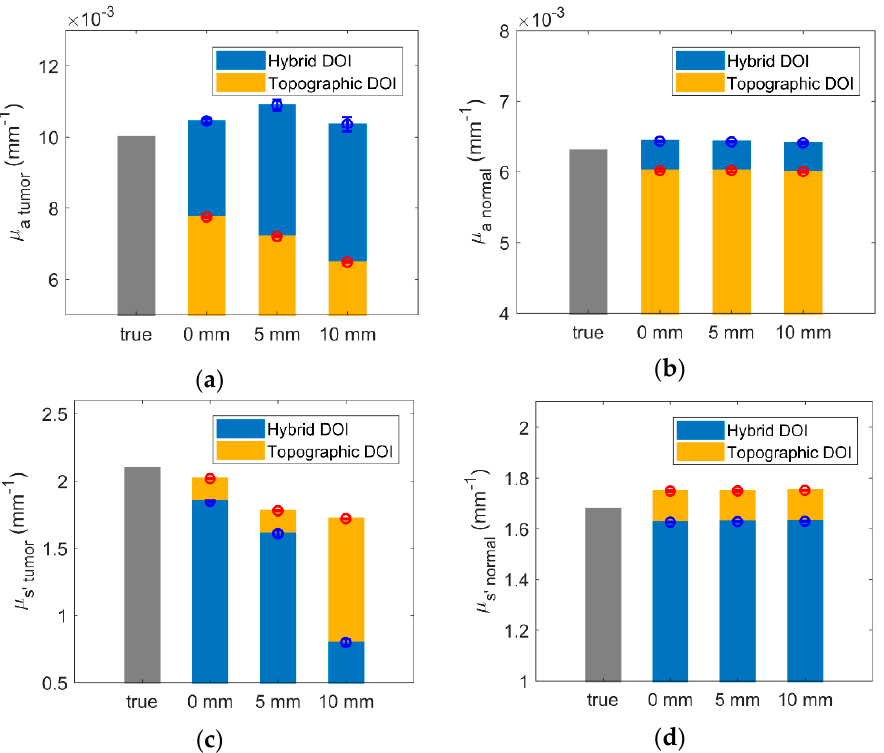
Figure 8. Bar plot representation of ground truth (gray), hybrid DOI, and conventional topographic DOI simulated recovery in µ a at 650 nm for ( a ) tumor and ( b ) normal tissue and µ s (cid:48) at 650 nm for ( c ) tumor and ( d ) normal tissue. Table 2. Di ff erence and percent di ff erence of recovered µ a and µ s (cid:48) from true µ a and µ s (cid:48) at 650 nm. Depths